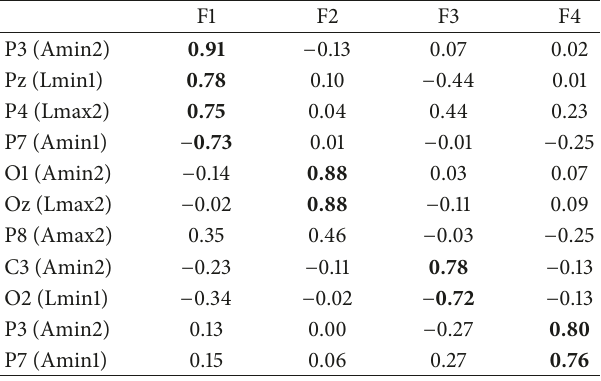
Table 2: Factor Analysis loadings for Varimax rotated matrix of four-factor model explaining about 70% of the total dataset variance (presented in bold if absolute values are greater than 0.7 ).